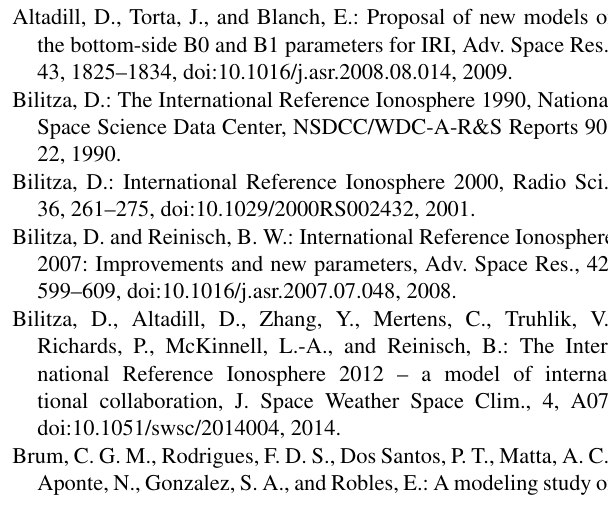
Fig. 3. The underestimation observed during the solar maxi- mum 2001–2002 is consistent with the results Themens and Jayachandran (2016) found using Canadian GPS-TEC data during the most recent solar maximum. They attributed this underestimation to the topside thickness parameterization in the IRI